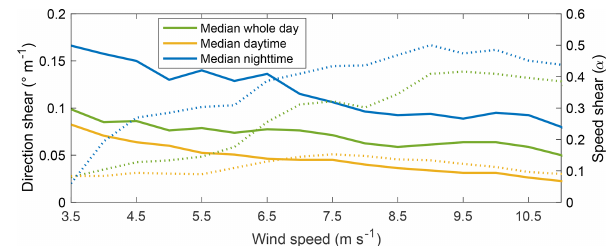
Figure 10. Direction (solid line) and speed (dotted line) wind shear variation with 80m wind speed using each day’s sunrise and sunset times of day.